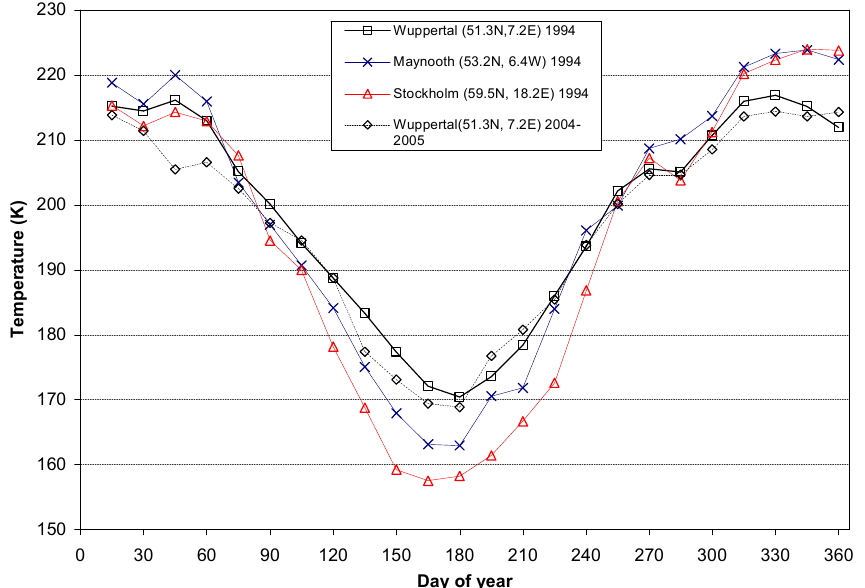
Fig. 3. A comparison of OH*(3,1) rotational temperatures recorded at 3 ground-based stations, Stockholm (59.5 ◦ N, 18.2 ◦ E), Maynooth (53.2 ◦ N, 6.4 ◦ W) and Wuppertal (51.3 ◦ N, 7.2 ◦ E) for 1994. Also shown for comparison purposes are monthly averaged temperatures for Wuppertal for